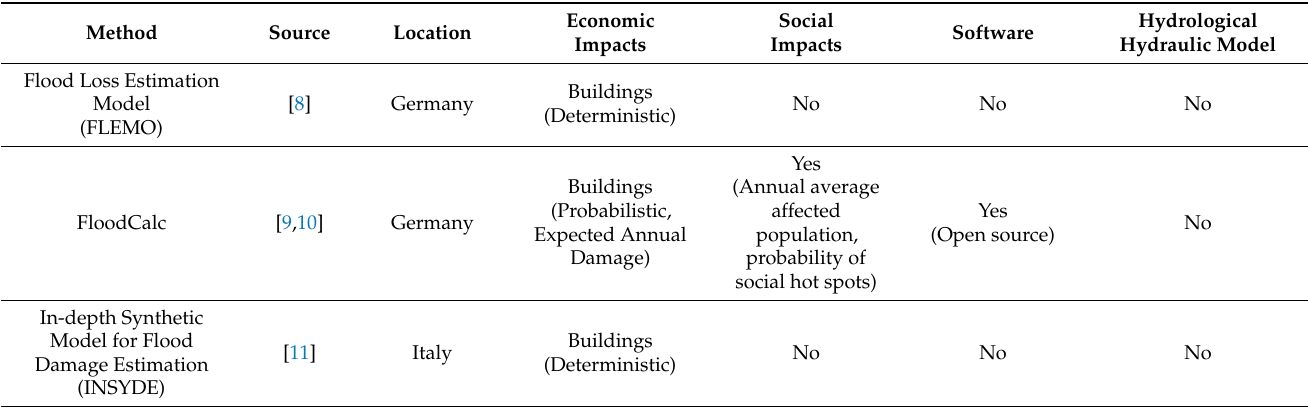
Table 1. Characteristics of the different methods for flood risk